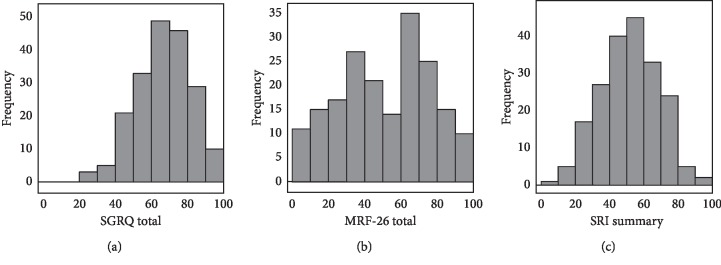
Frequency distribution of each HRQL score. (a) The SGRQ total; (b) the MRF-26 total; and (c) the SRI summary. Higher scores indicate worse HRQL in the SGRQ and MRF, and vice versa, in the SRI.